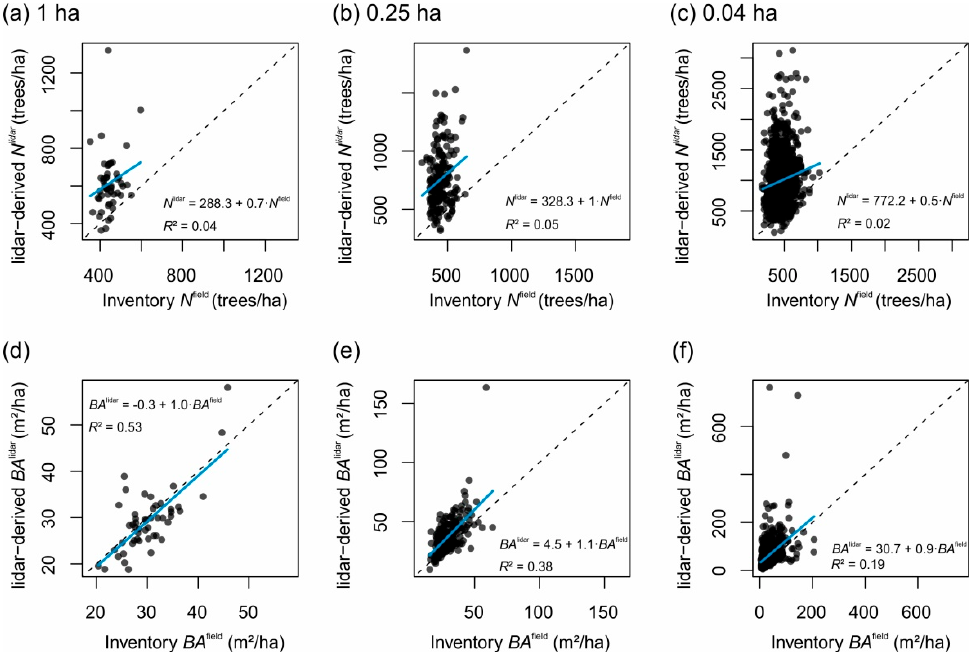
Figure 6. Comparison of lidar-derived and inventory-based ( a – c ) tree density ( N ) and ( d – f ) basal area ( BA ) for the ( a , d ) 1-ha scale, ( b , e ) 0.25-ha scale, and ( c , f ) 0.04-ha scale. Each black dot represents one subplot of the respective spatial scale. Dotted lines denote the 1:1 line. Blue lines show the linear regression line (with its equation and R ² shown in each panel). Values on the bias , RMSE , and nRMSE are provided in Table 3. Please note the different axis ranges and sample sizes for the different spatial scales (see also Table 3).